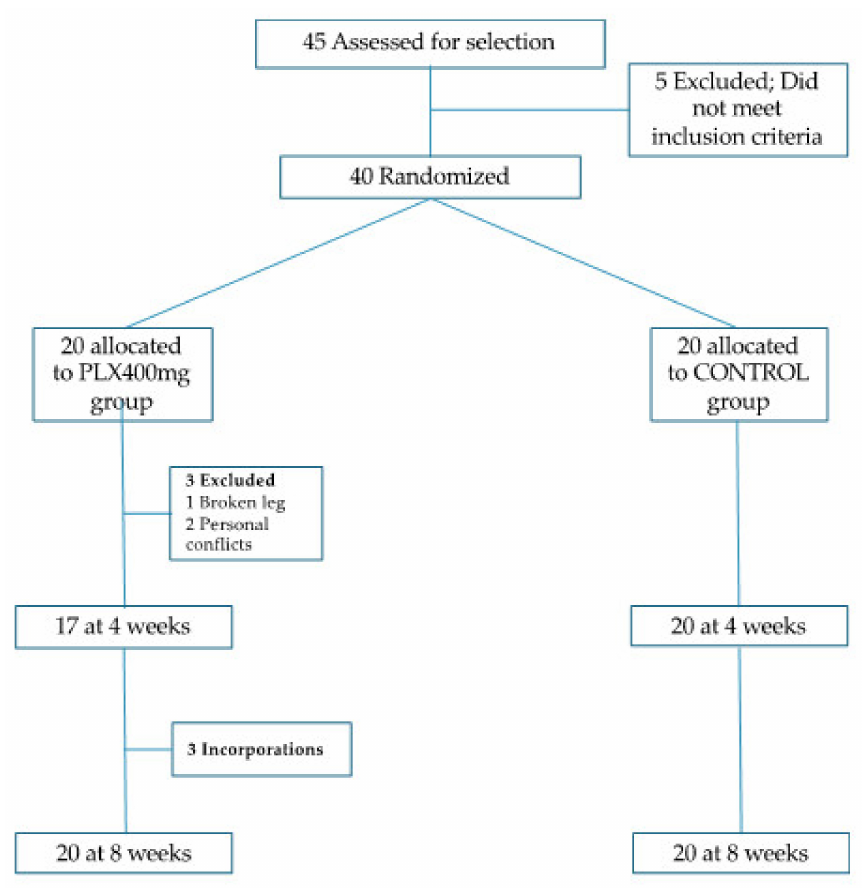
Figure 1. Participant’s